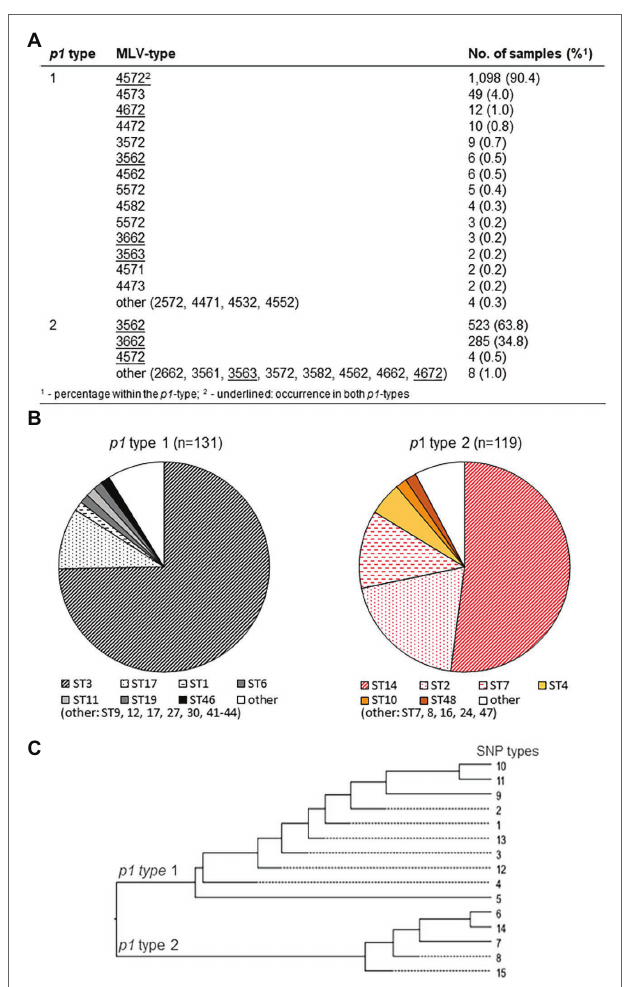
FIGURE 1 | Association of main p1 types 1 and 2 (including variants) with multi-locus variable-number (MLV; A ; using data of Benitez et al., 2012; Brown et al., 2015; Dumke et al., 2015; Touati et al., 2015; Kogoj et al., 2018; Zhao et al., 2019; Kenri et al., 2020; Xiao et al., 2020; Dumke and Rodriguez, 2021; Meyer Sauteur et al., 2021), MLS ( B ; data of Brown et al., 2015; Kenri et al., 2020; Meyer Sauteur et al., 2021; and Dumke and Rodriguez, 2021), and single nucleotide polymorphism (SNP) types ( C ; data of Touati et al., 2015; Kenri et al., 2020; Dumke and Rodriguez, 2021),